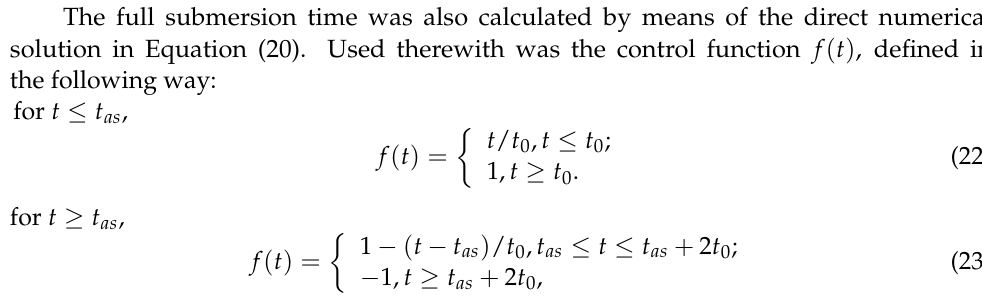
Figure 10. Speed of submersion of a sphere from the start of deceleration until complete stop consid- ering the subsequent ascension for an instantaneous change in buoyancy ( t 0 = 0 ) from − η to η